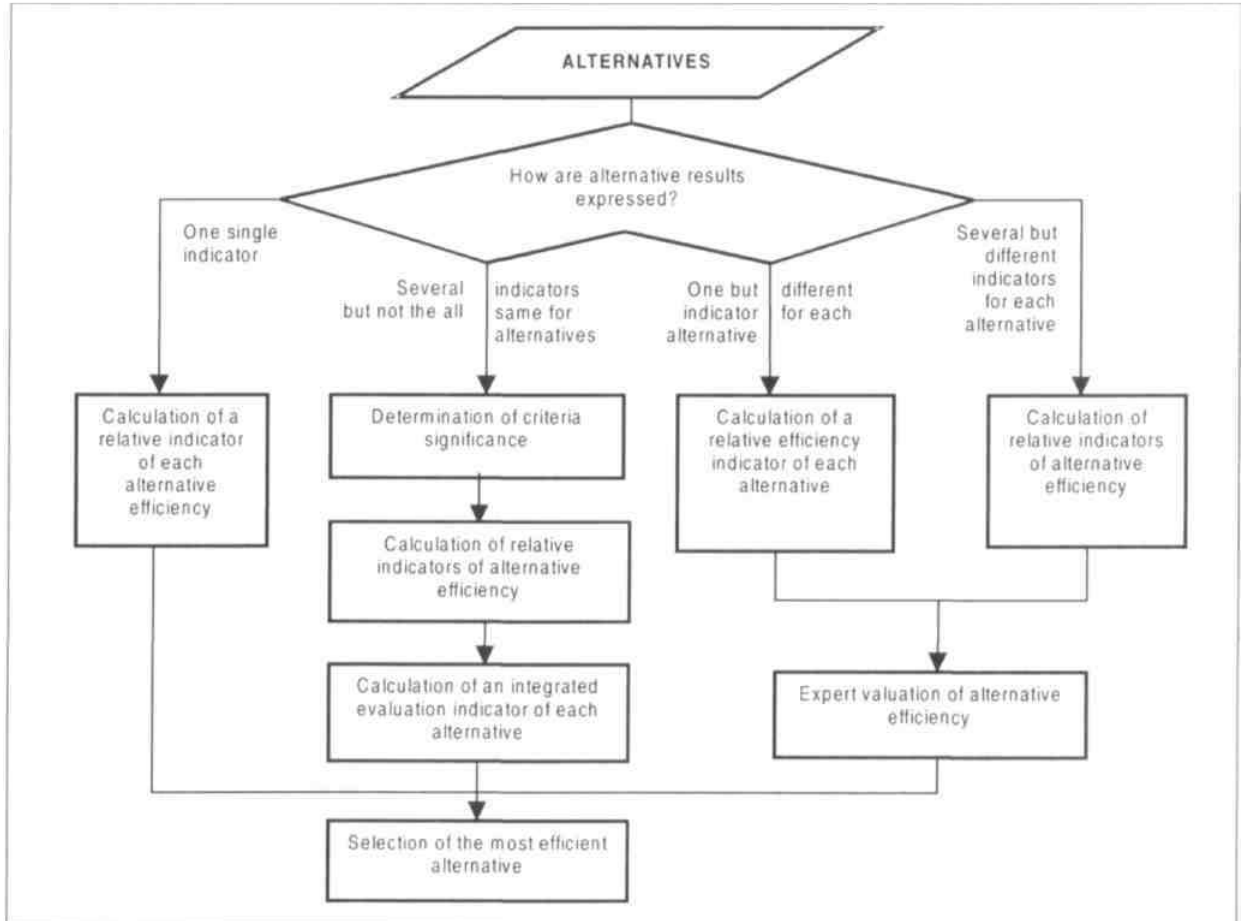
Fig 3. Technological sheme of programme evaluation on the level of measures and